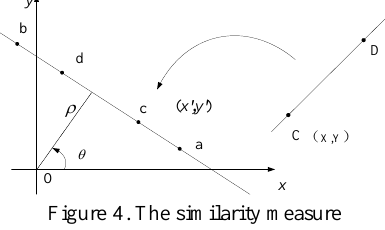
Figure 4. The similarity